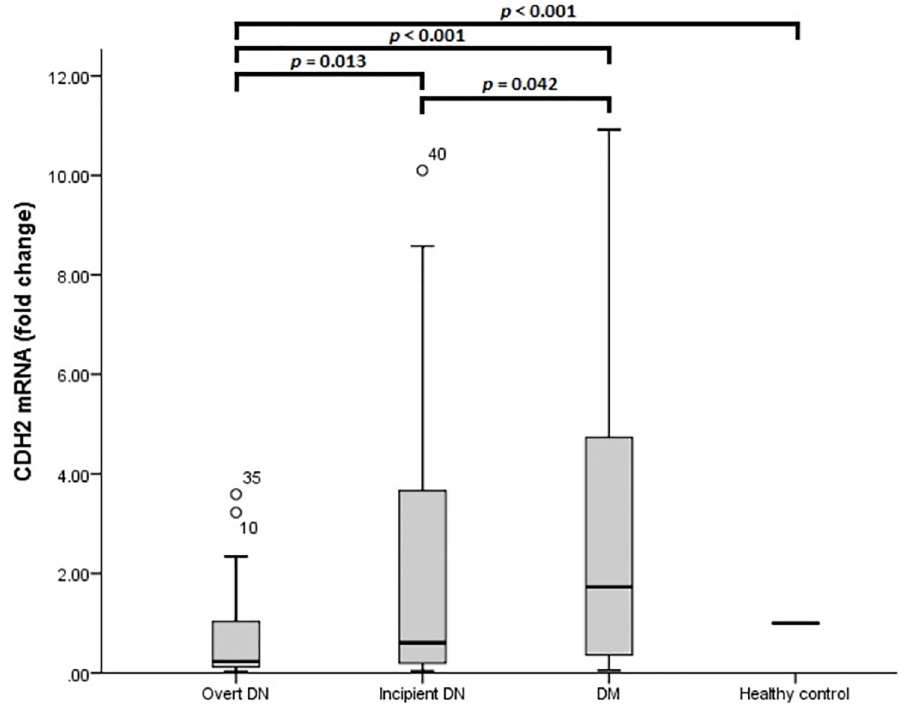
Fig 2. CDH2 mRNA expression level in blood extracellular vesicles. p value is calculated by the Mann–Whitney U test.